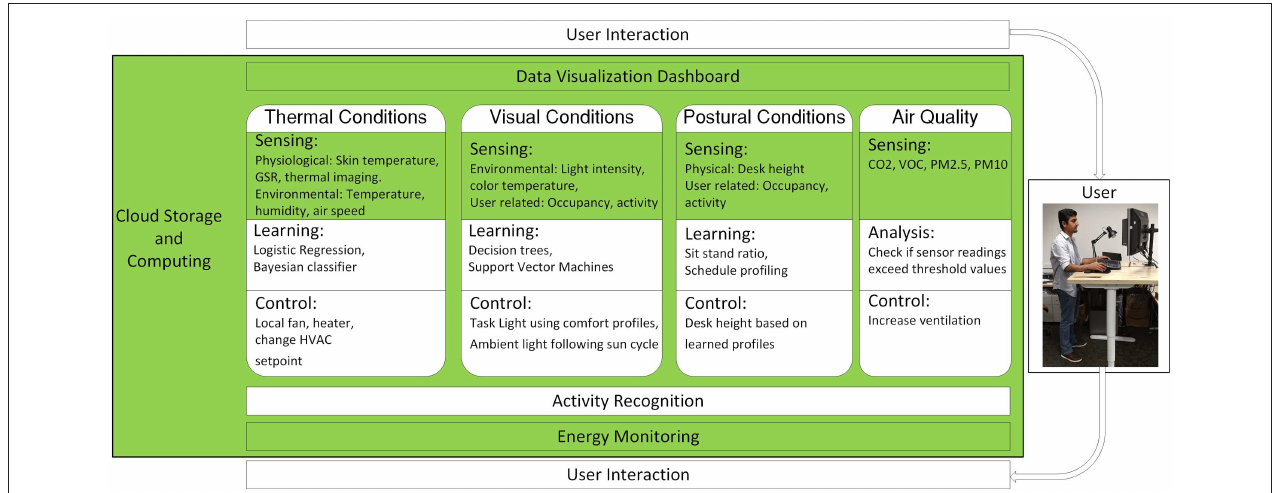
FIGURE 1 | Overall Framework of the desk. Green color represents components already implemented in the prototype.